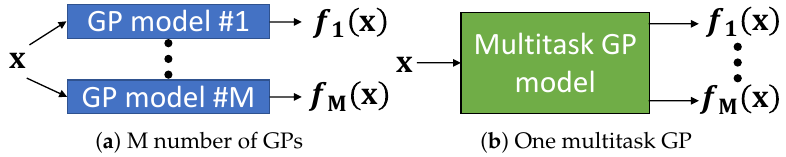
Figure 1. Multitask Gaussian